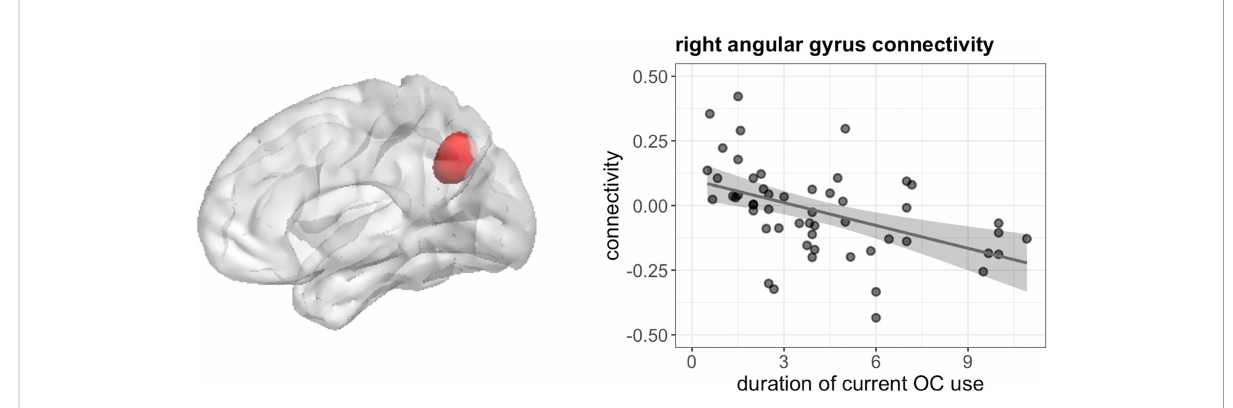
FIGURE 8 Negative association between duration of OC use and connectivity between left hippocampus and right angular gyrus in current users during